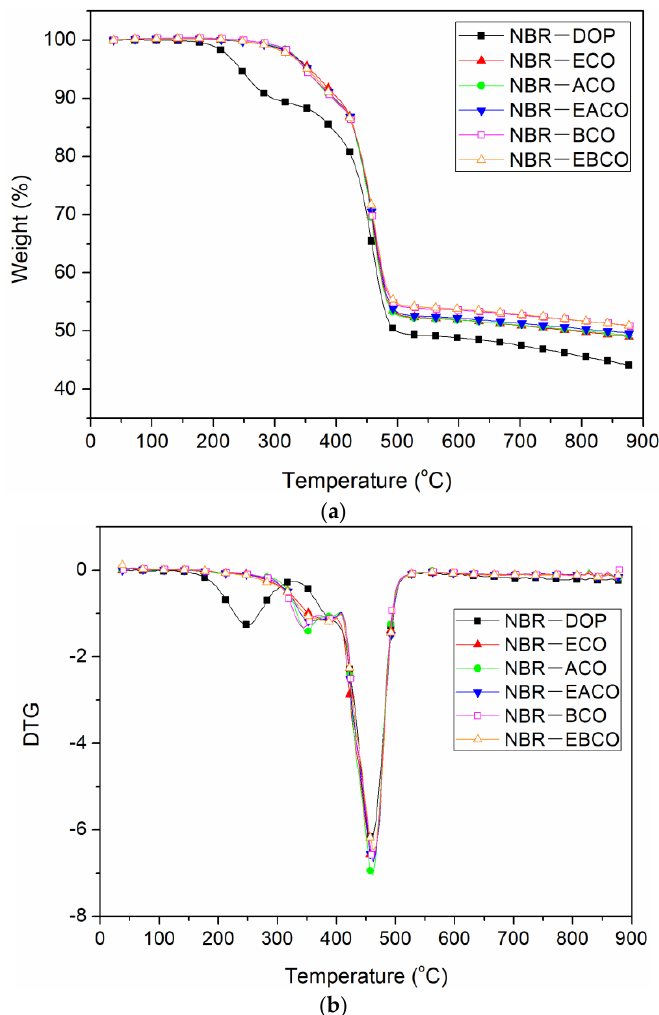
Figure 7. TGA curve ( a ) and DTG curve ( b ) of NBR vulcanizates.